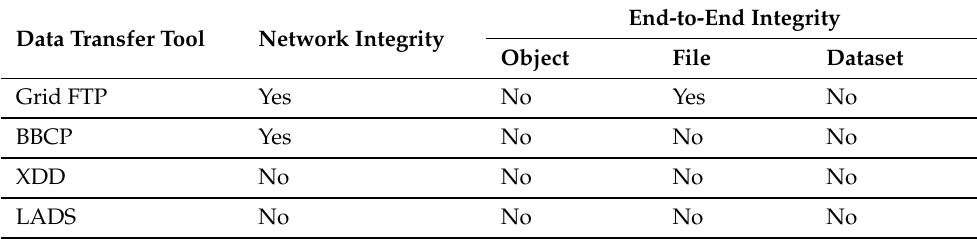
Table 1. Summary of data integrity